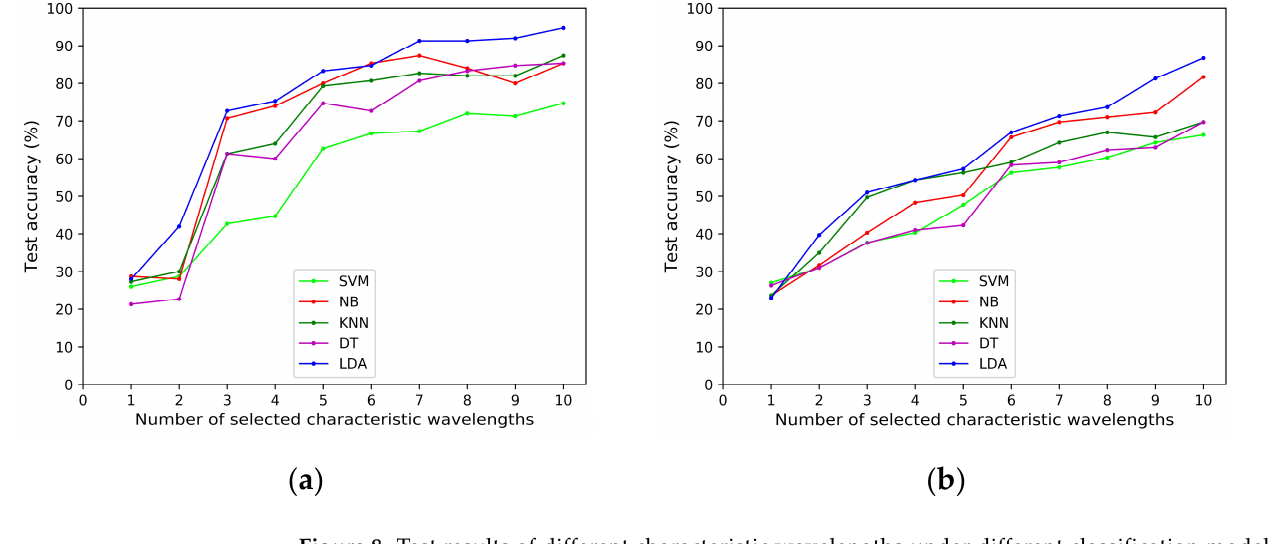
Figure 8. Test results of different characteristic wavelengths under different classification models. ( a ) Test results of characteristic wavelength selection by CARS-GDI. ( b ) Test results of characteristic wavelength selection by SPA-GDI.